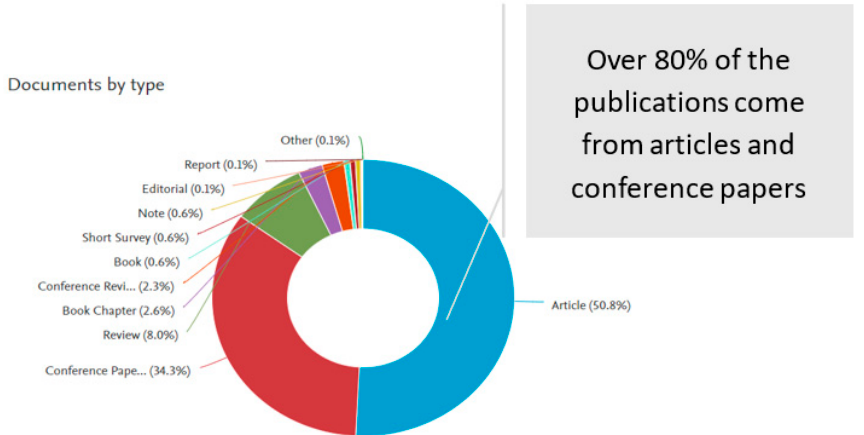
Figure 12. SCOPUS: advanced AND production AND control—Documents by Type.